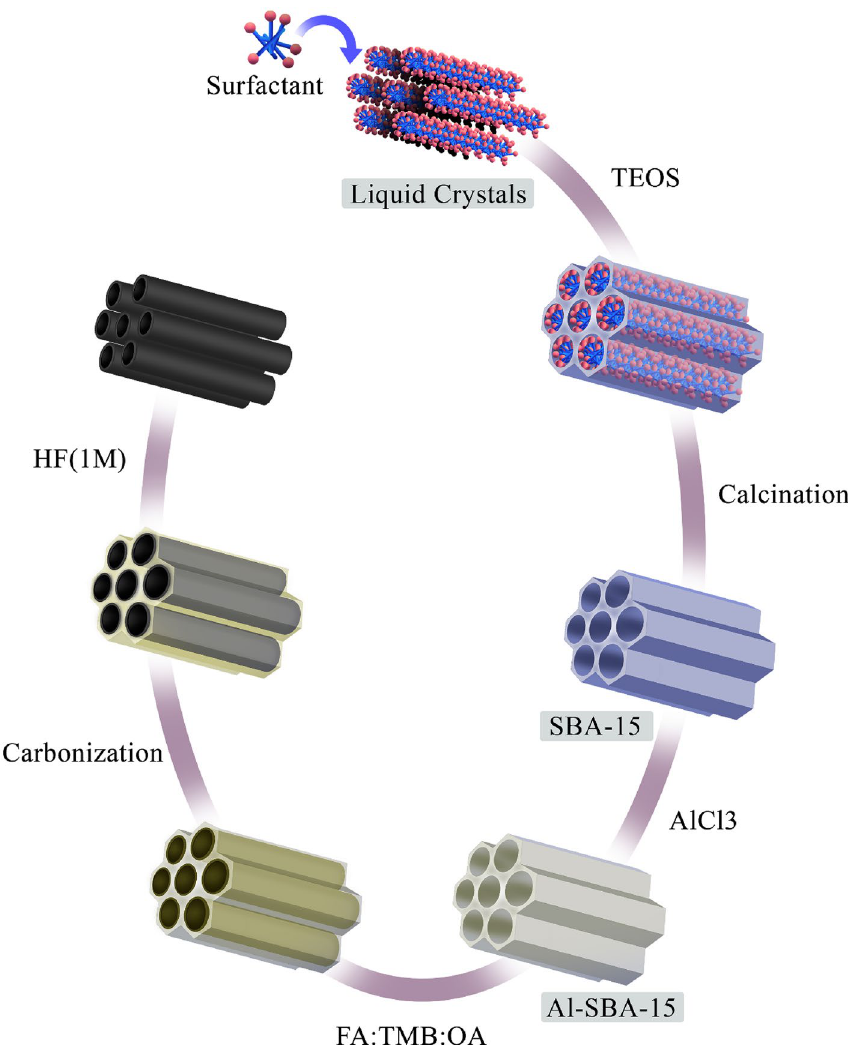
Figure 3. Schematic representation of the preparation procedure of CMK-5 mesoporous carbon by the nanocasting strategy using an Al-SBA-15 hard